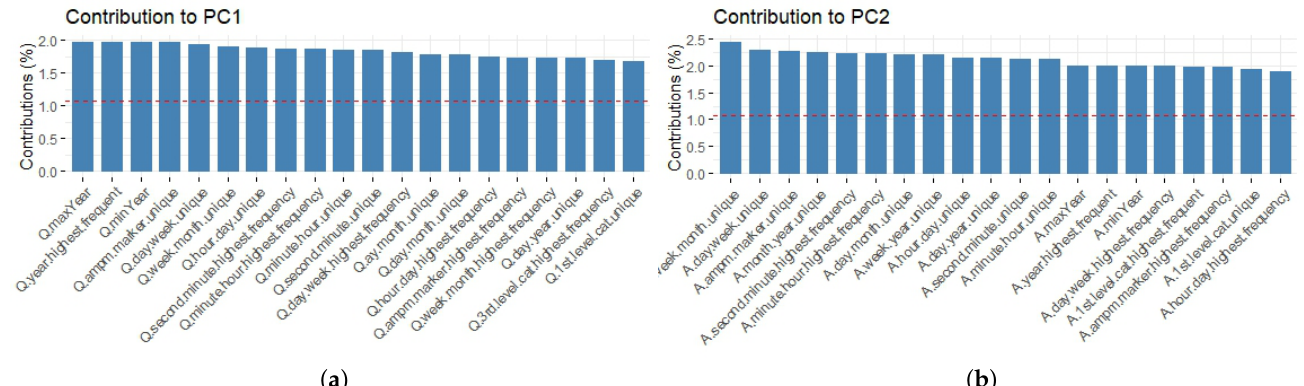
Figure 7. Contributions to the first (PC1) ( a ) and second (PC2) ( b ) components by the 20 most significant variables. The red line represents the threshold for the significant variables (see variable descriptors on Appendix A).